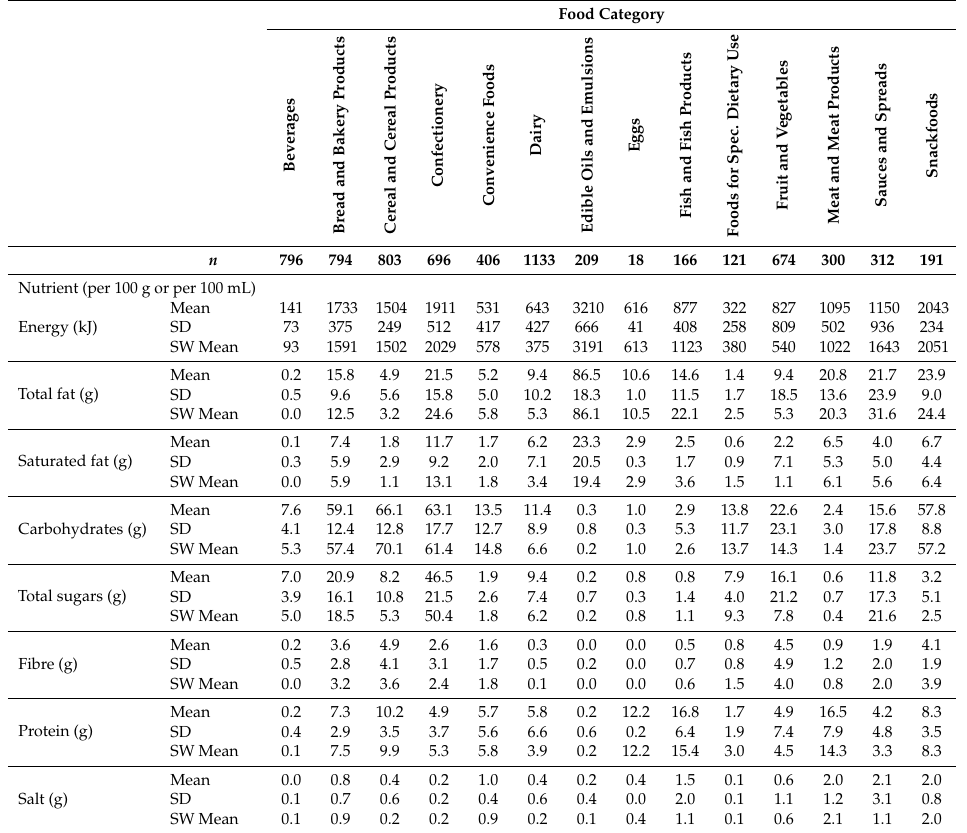
Table 1. Overview of foods in the market, their mean nutritional values with standard deviation and sales weighted mean per food category. n denotes number of products; SW denotes sales weighted